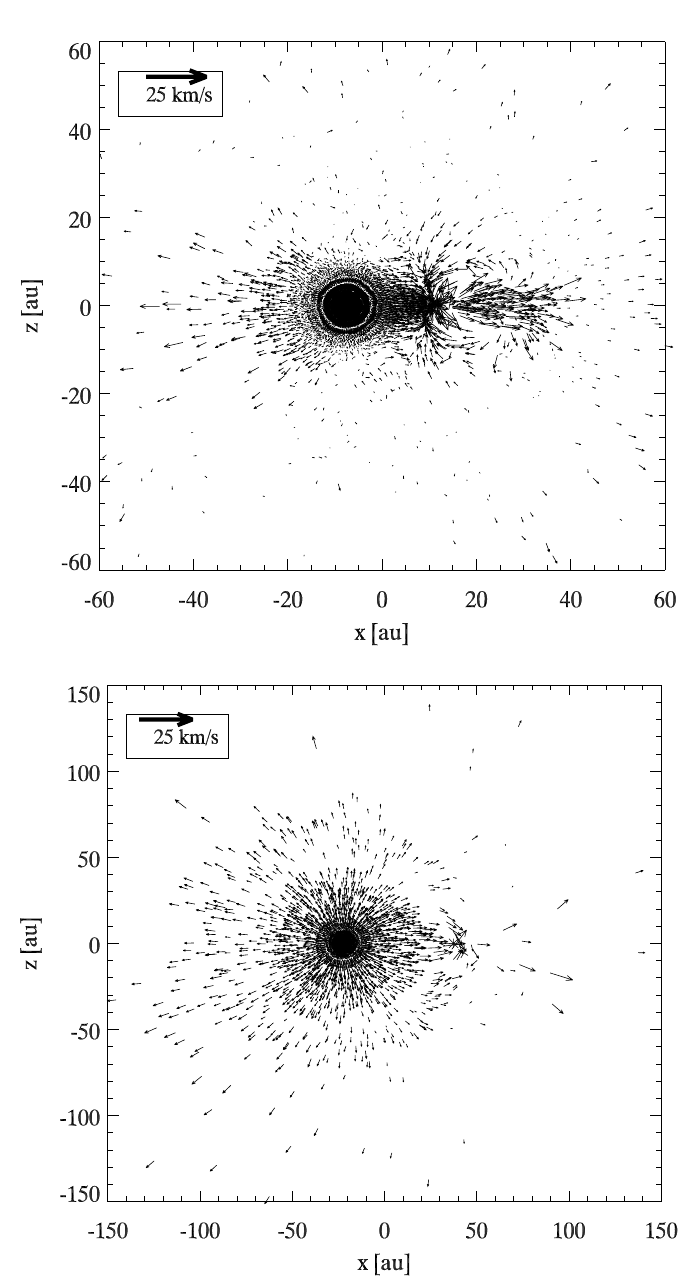
Fig. 2. The same as in Figure 1, but showing the velocity (cid:13)ow structure for models M1 (top) and M2 (bottom) perpendicular to the orbital plane, i.e., in the xz